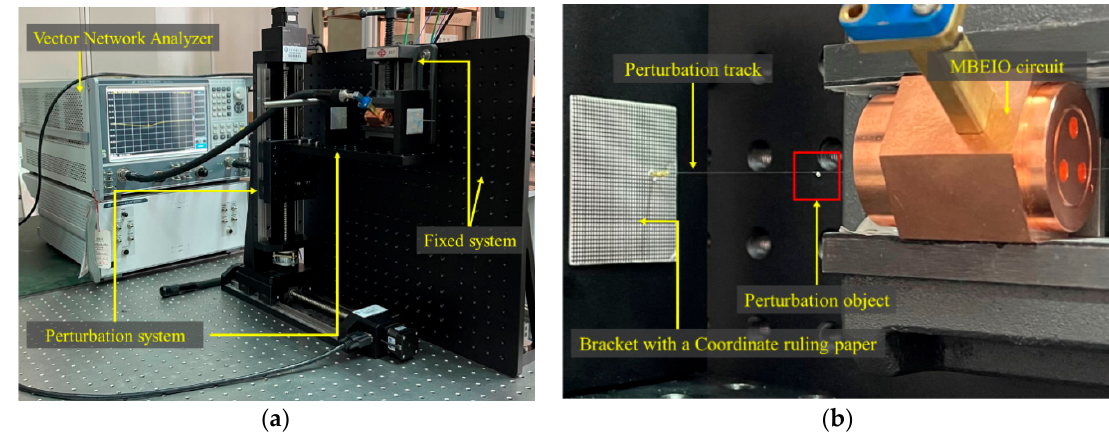
Figure 10. ( a ) Schematic of the complete measurement setup. ( b ) Schematic of the partial perturbation system and the radii of the perturbation object which is made of glass is 0.325 mm.